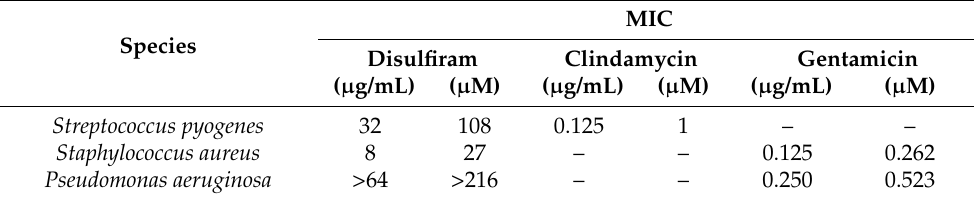
Table 1. Antibacterial activity of disulfiram compared with gentamicin and clindamycin.